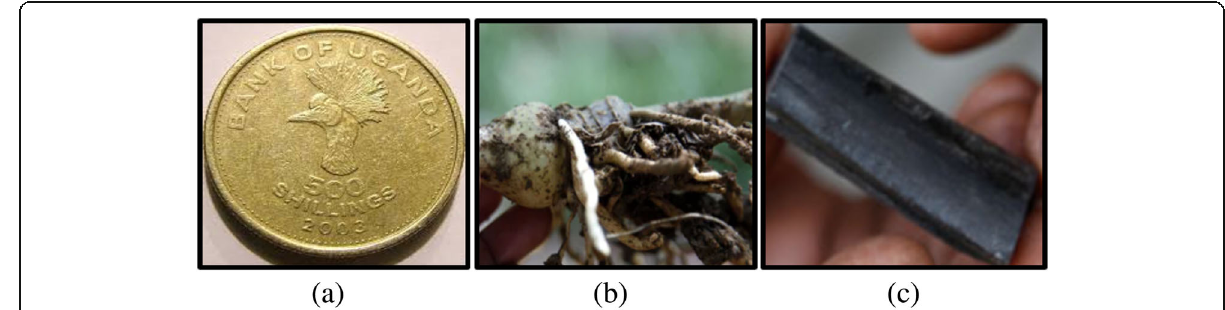
Fig. 6. Treatment of snake bites in Uganda. a 500 Uganda shillings copper coin. Side displayed is usually placed on the bite. b Haemanthus multiflorus bulb. c black